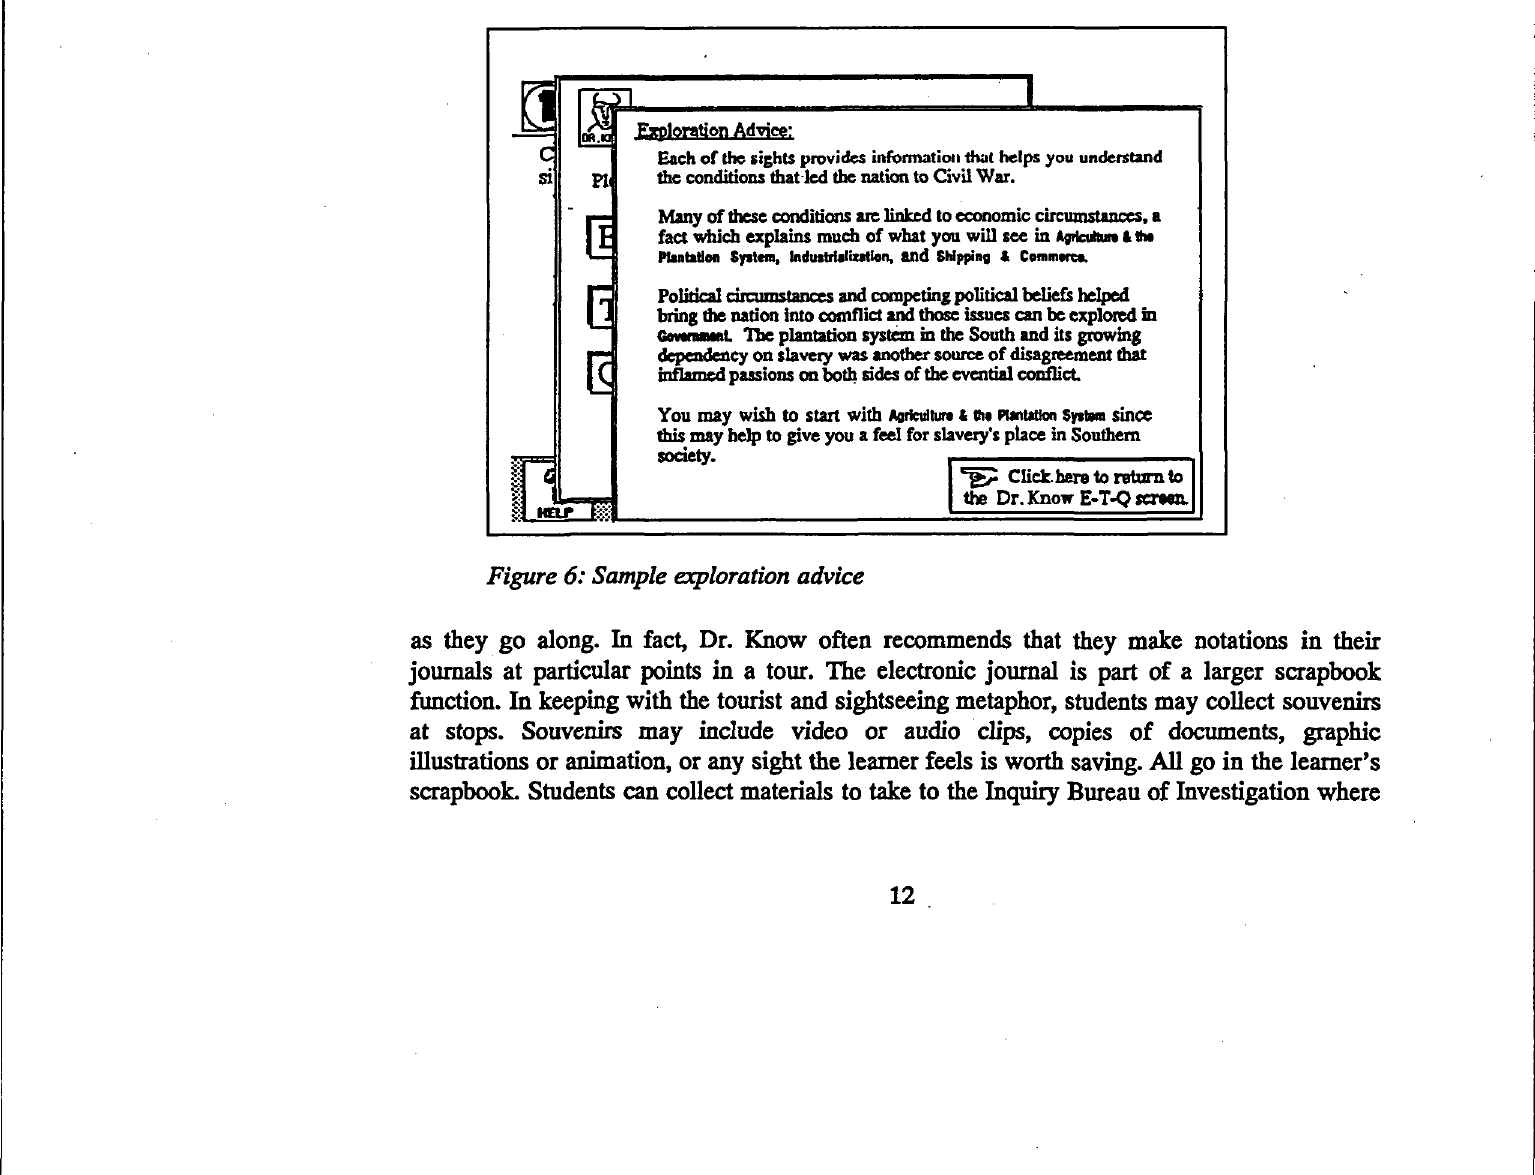
Figure 5: Dr Know's E?T-Q advice selection screen